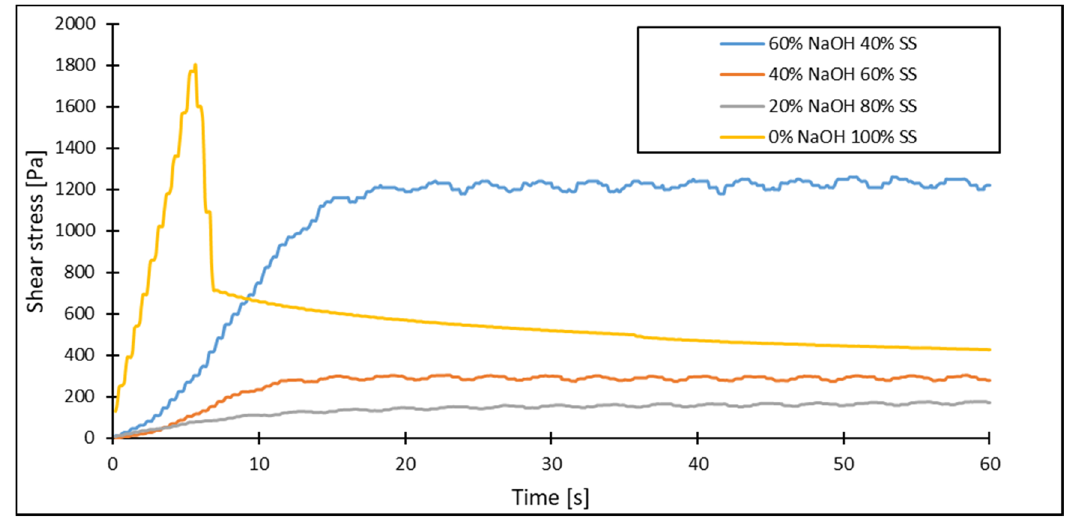
Figure 9: Rheological curves of a geopolymer paste based on copper glues with di ff erent compositions of alkaline